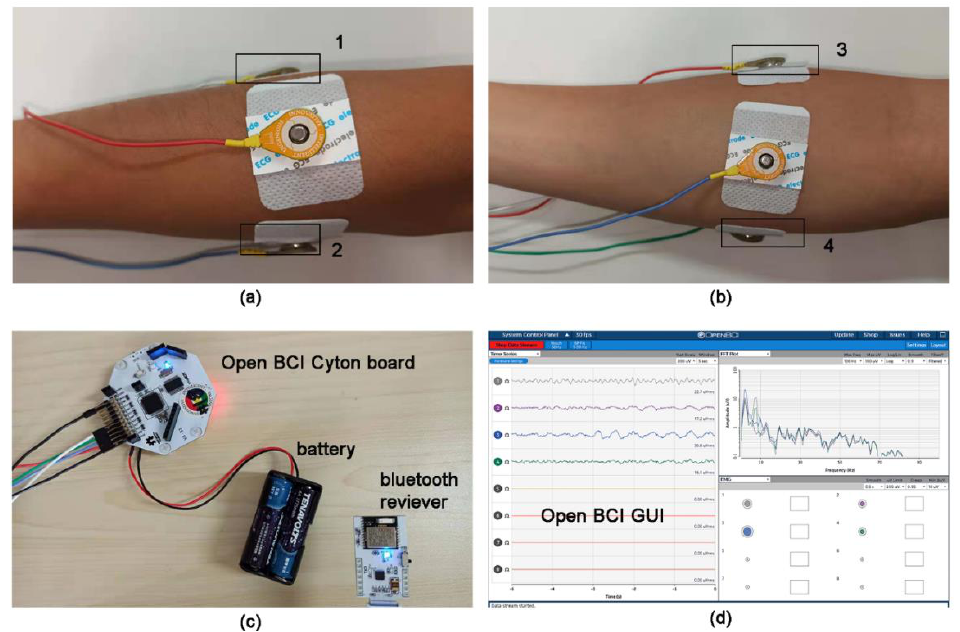
Figure 4. The process of surface electromyography (sEMG) collection. ( a ) The electrode positions of 1 and 2. ( b ) The electrode positions of 3 and 4. ( c ) The hardware for sEMG collection. ( d ) The software of sEMG collection.